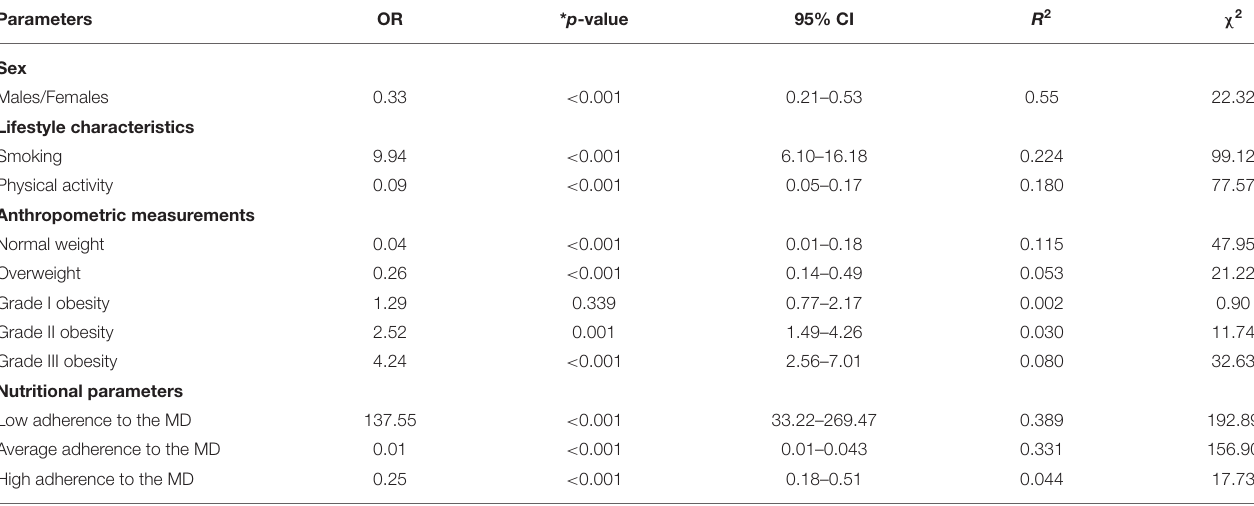
TABLE 7 | Results of a multinomial logistic regression to assess the association between the cytology categories (TIR2, TIR3a, TIR3b vs. TIR4/TIR5) and categorical variables included in this study. Parameters